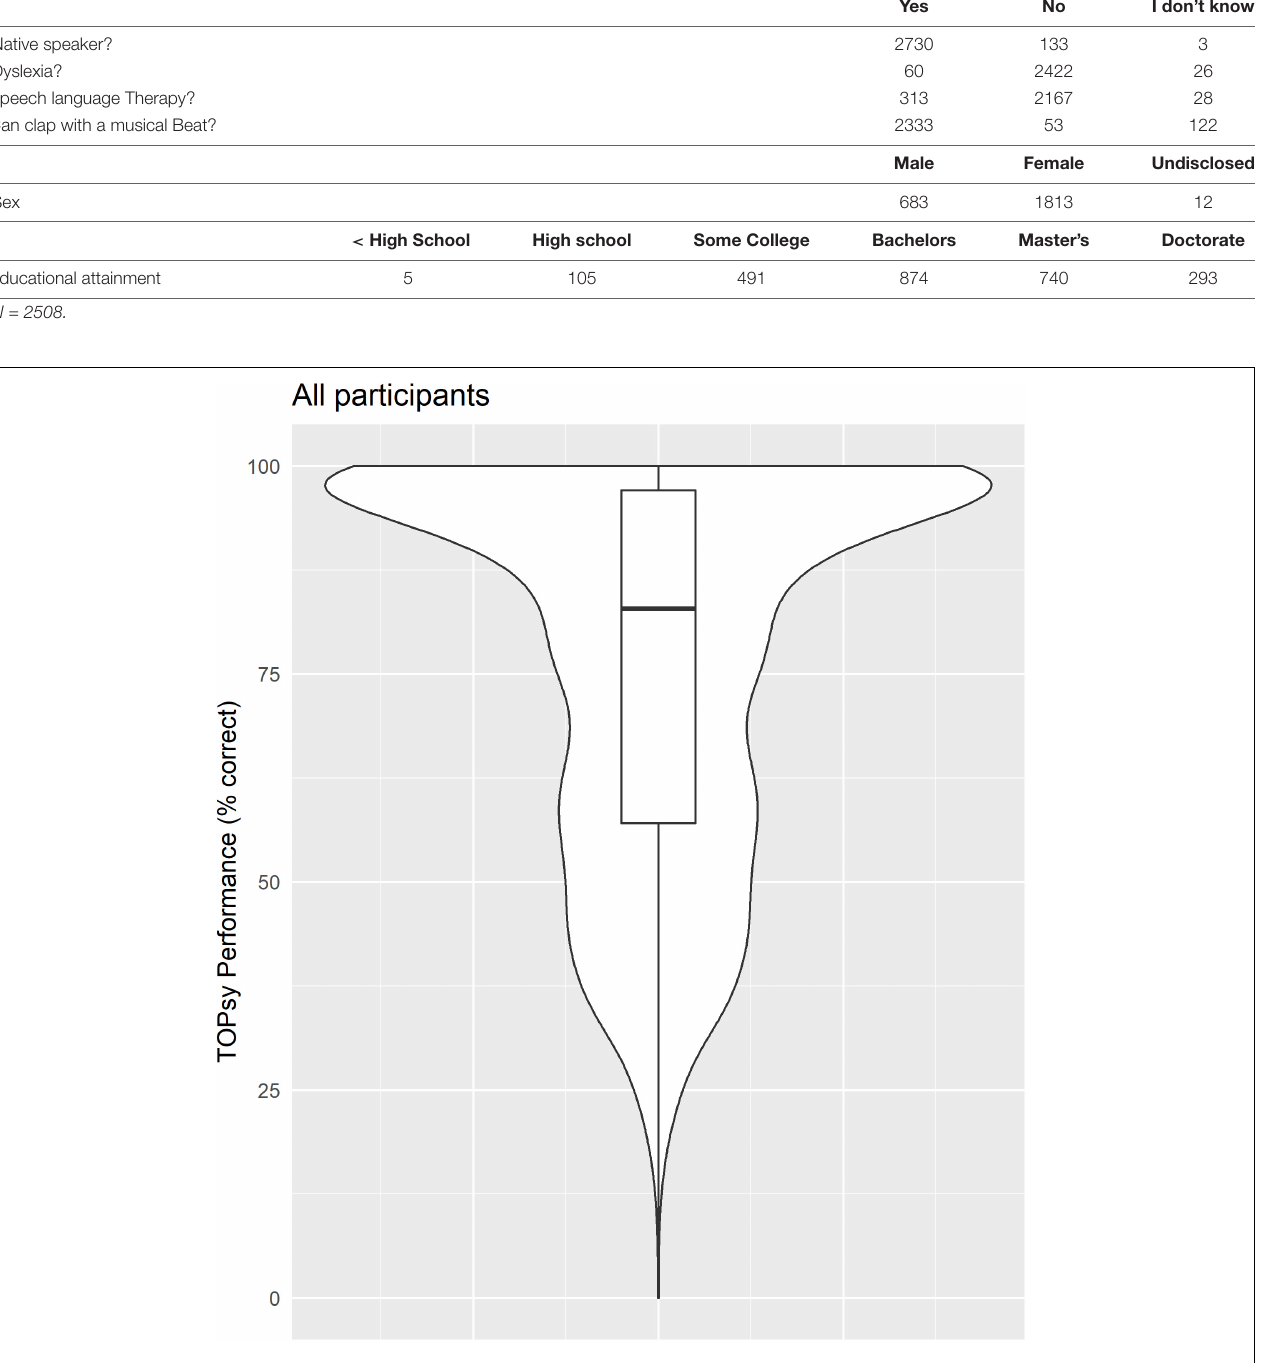
Frontiers in Neuroscience |